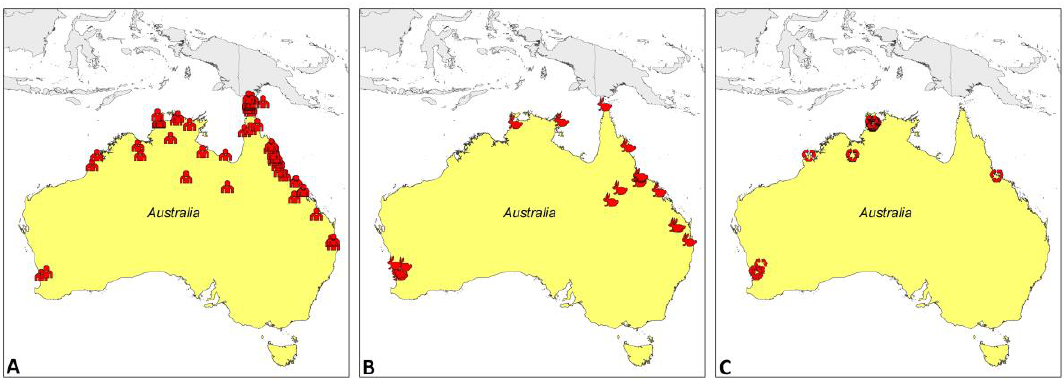
Figure 1. The geographic distribution of confirmed human cases ( A ), animal cases ( B ), and environmental isolates ( C ) of culture-confirmed B.